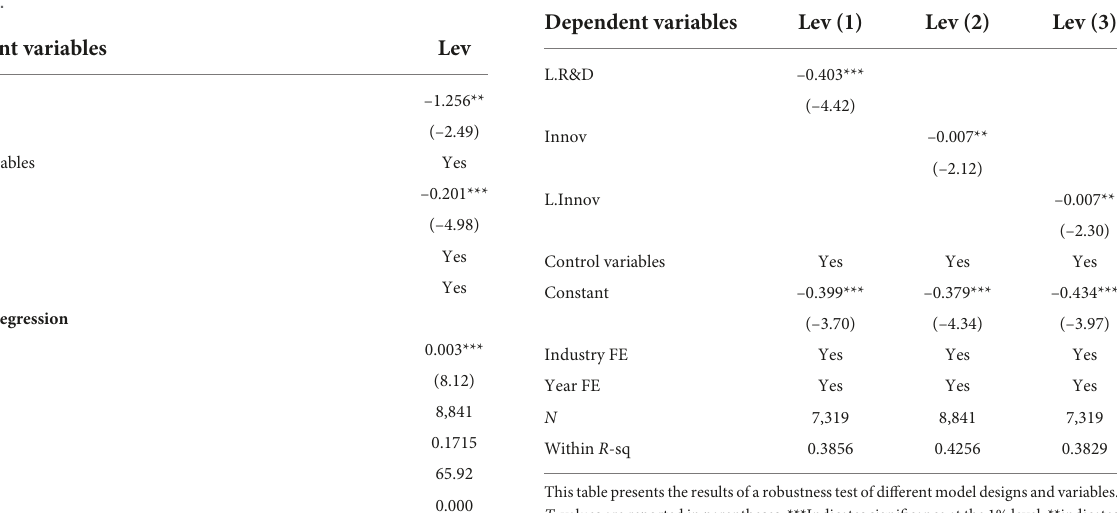
TABLE 9 The results of different models and